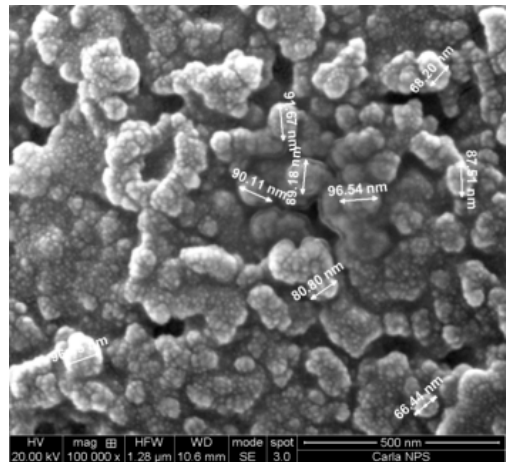
Figure 2. Representative scanning electron microscopy (SEM) image of ICD@SS@SPIONs.